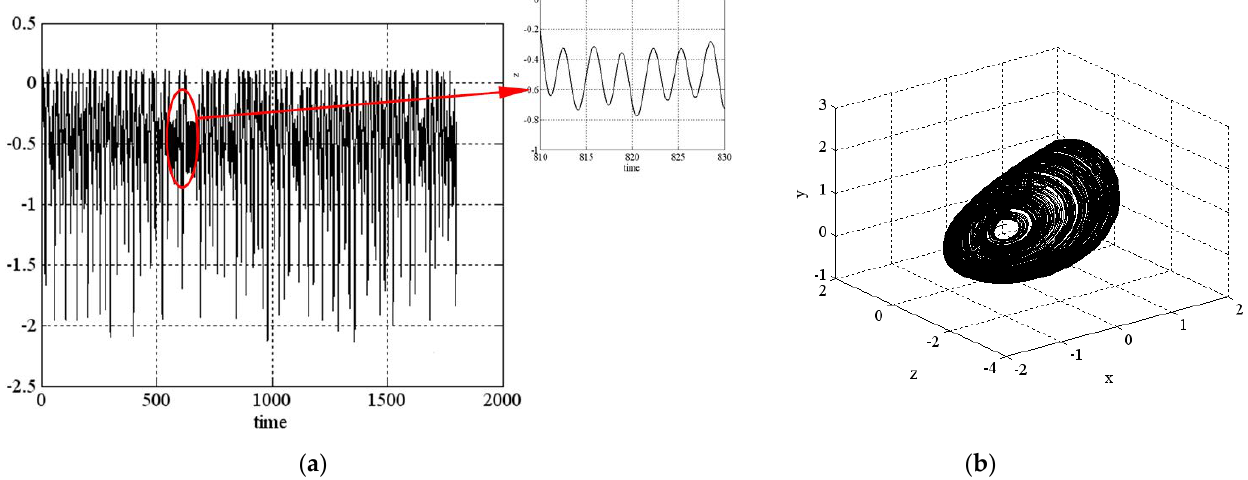
Figure A3. Chaotic solution ( a ) and strange attractor ( b ) for system (1), when a = b = 0.5.